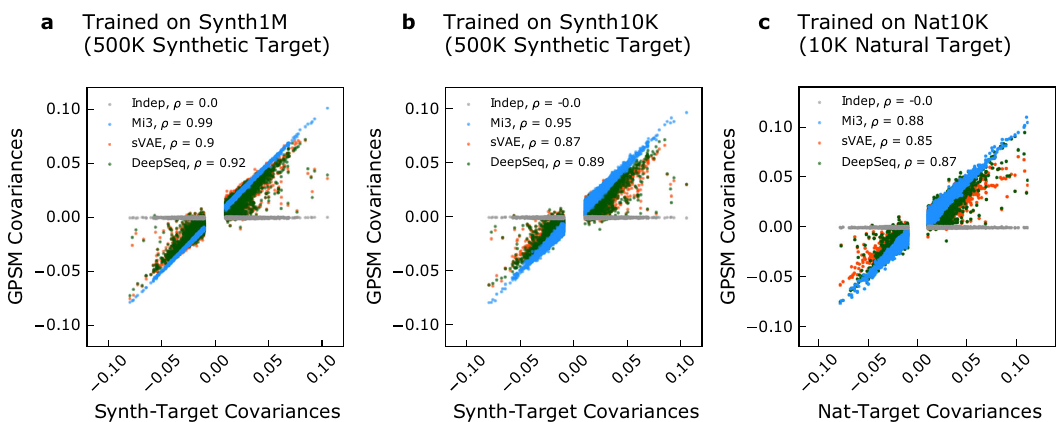
Fig. 2 Ability of GPSMs to capture pairwise covariances. Mi3 (blue), DeepSequence (green), sVAE (orange), and Indep (gray) MSA statistics are compared to the target probability distribution values. GPSMs were trained on 1M synthetic (Synth1M, a ), 10K synthetic (Synth10K, b ), or 10K natural (Nat10K, c ) kinase sequences from the corresponding target probability distribution. Covariances C ij αβ were computed from MSAs of 500K sequences generated by each GPSM ( y -axis) vs. target covariances ( x -axis) computed from MSAs of 500K sequence from the target probability distribution ( a , b ) or from 10K natural target sequences ( c ), with Pearson correlation ρ shown for each comparison. Generative capacity only slightly decreases as training sample size is reduced for all GPSMs from panels a to b , indicating insensitivity to training sample size. Covariances around zero are omitted to simplify the plot, but are included in the Pearson kinase sequence data using Mi3 in our natural analysis (Fig. 1)